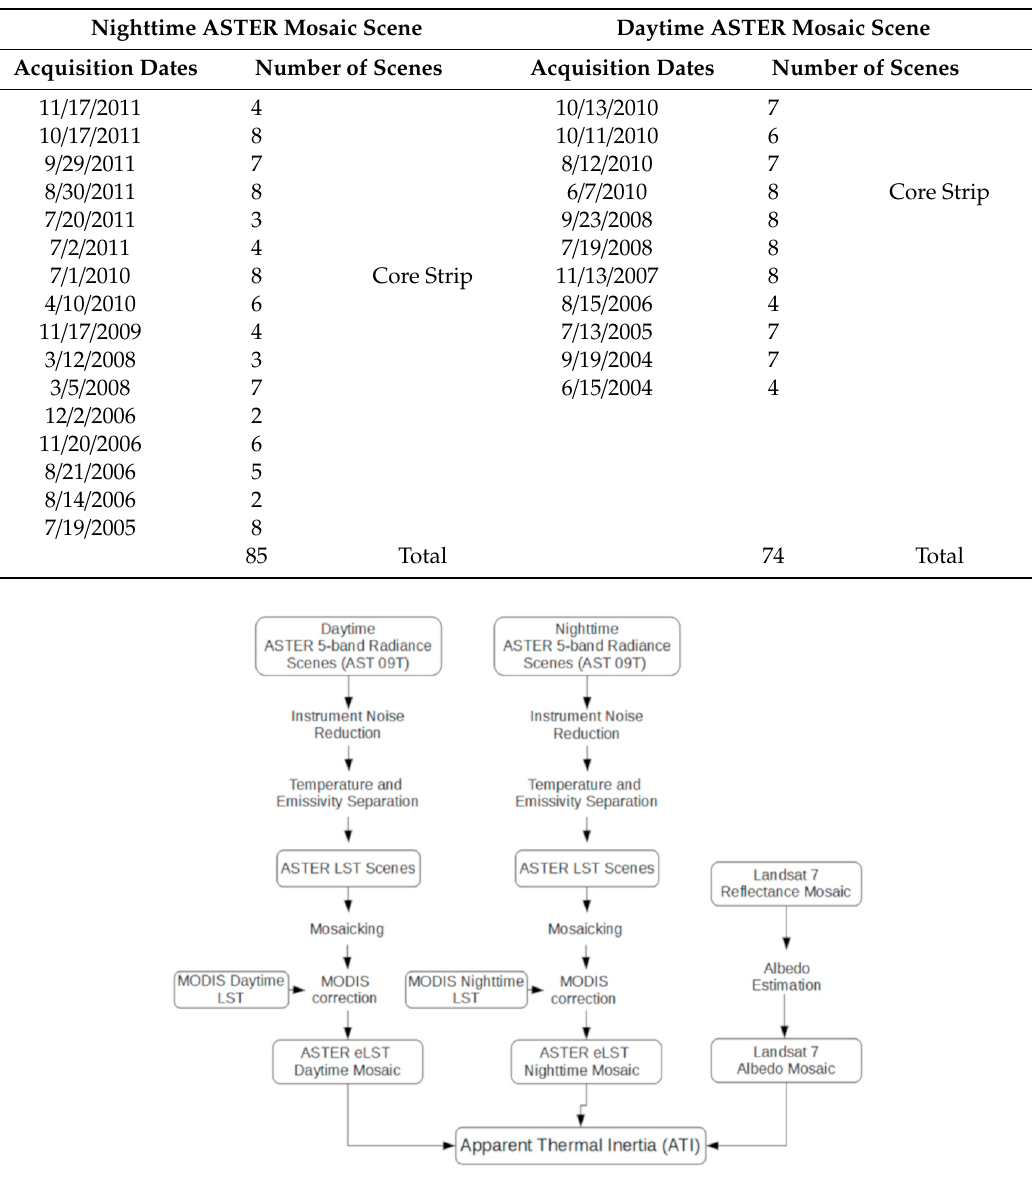
Table 1. Acquisition Dates for daytime and nighttime ASTER TIR Mosaics. Each date represents a continuous strip of scenes collected in the same orbit path.